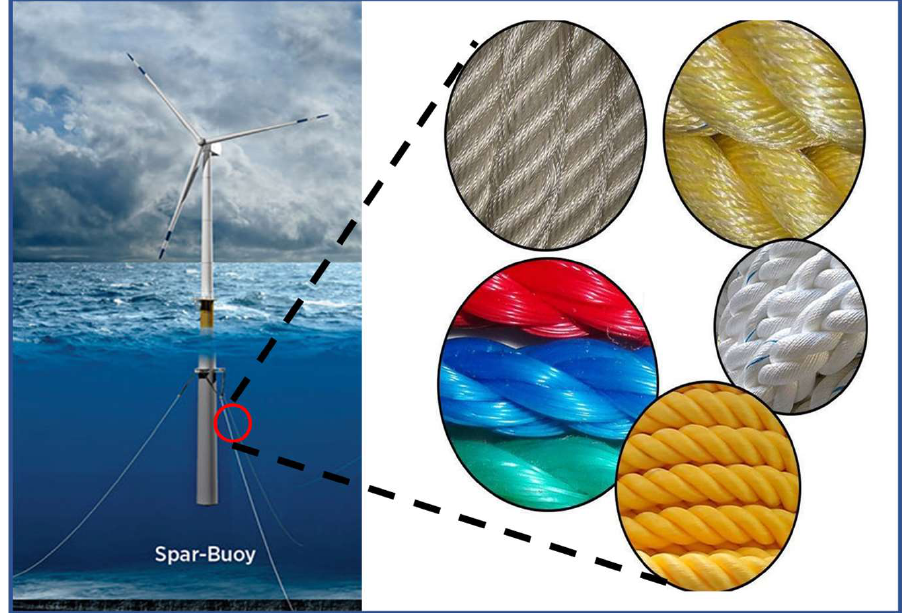
Figure 1. Synthetic fibers applied into the taut mooring system of floating wind turbine.